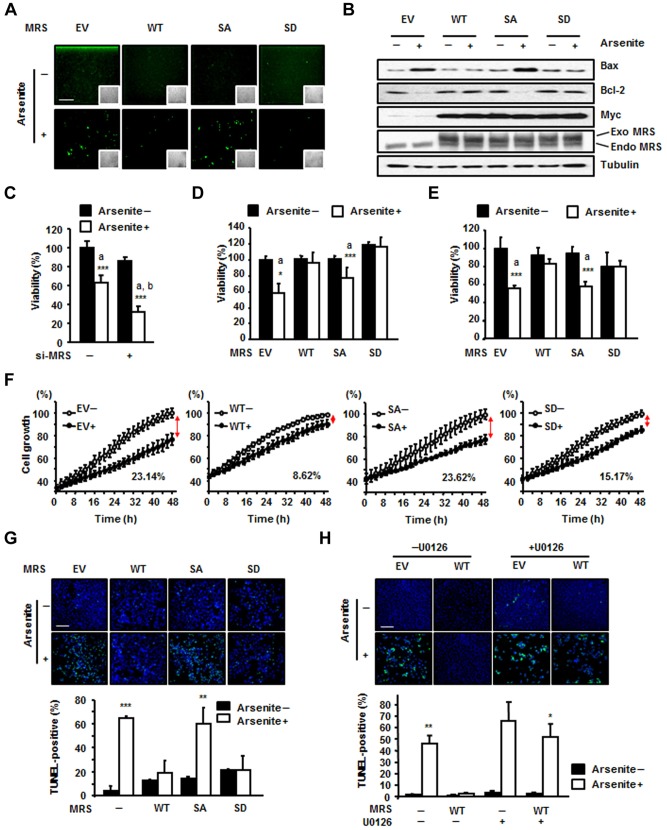
Dually phosphorylated MRS reduces intracellular ROS levels and promotes cell survival under ROS stress. (A) HEK293T cells were transfected with empty vector (EV) or Myc-tagged wild-type (WT) MRS, or the SA or SD mutants, and incubated with arsenite. ROS levels were detected by the DCFH-DA assay. Insets show the same field as in the phase-contrast images. Scale bar: 200 µm. (B) Bax and Bcl-2 levels were detected with their specific antibodies under the same conditions as shown in A. Exogenous (Exo) and endogenous (Endo) MRS were separated and detected using the anti-MRS antibody to show the expression level. (C) MRS level in HEK293T cells was reduced by treatment with MRS-specific siRNA (si-MRS) for 72 h. The effect of MRS expression on cell viability under ROS stress was determined by the MTT assay. (D,E) The effect of MRS proteins on cell viability under ROS stress was determined by the MTT assay. MRS proteins were transiently expressed in HEK293T cells (D) and stably expressed in HeLa cells (E). In C–E: a, P-value indicates a significant difference between the arsenite-untreated and -treated groups; b, P-value indicates a significant difference between arsenite-treated si-control and si-MRS groups. (F) The growth curves of MRS-expressing stably transfected HeLa cells were monitored in the presence and absence of ROS stress. (G) ROS-dependent apoptosis was determined in MRS-expressing stably transfected HeLa cells using the TUNEL assay. Cells incubated with or without arsenite for 72 h were fixed and stained with 4′,6-diamidino-2-phenylindole (DAPI; blue) and fluorescein-labeled dUTP. Green fluorescence indicates TUNEL-positive cells. Scale bar: 200 µm (upper panel). The number of TUNEL-positive cells was normalized to that of DAPI-positive cells, and the quantitative analysis is shown (lower panel). (H) HeLa cells expressing wild-type MRS were subjected to TUNEL assay as described for G with or without U0126 pre-treatment, and the images (upper panel) and the quantitative analysis (lower panel) for positive cells are shown. Scale bar: 200 µm. All quantitative data show the mean±s.d. (n = 3);*P<0.05; **P<0.01; ***P<0.001.